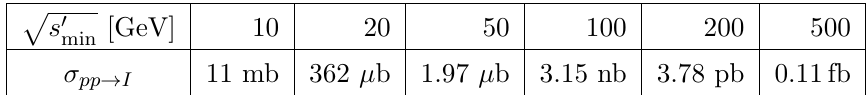
Table 2 . Hadronic cross sections for instanton production through initial gluons, at the 13 TeV LHC, using the NNPDF3.1 NNLO set with (cid:11) s ( M Z ) = 0 : 118